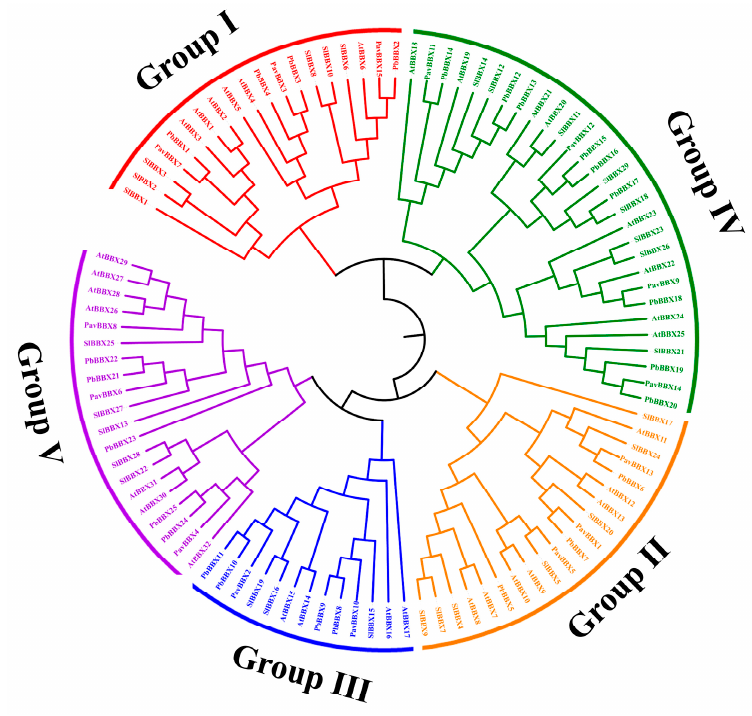
Figure 2. Phylogenetic analysis of BBX genes in sweet cherry ( Prunus avium ), pear ( Pyrus bretschneideri Rehd ), tomato ( Solanum lycopersicum ), and Arabidopsis ( Arabidopsis thaliana ).